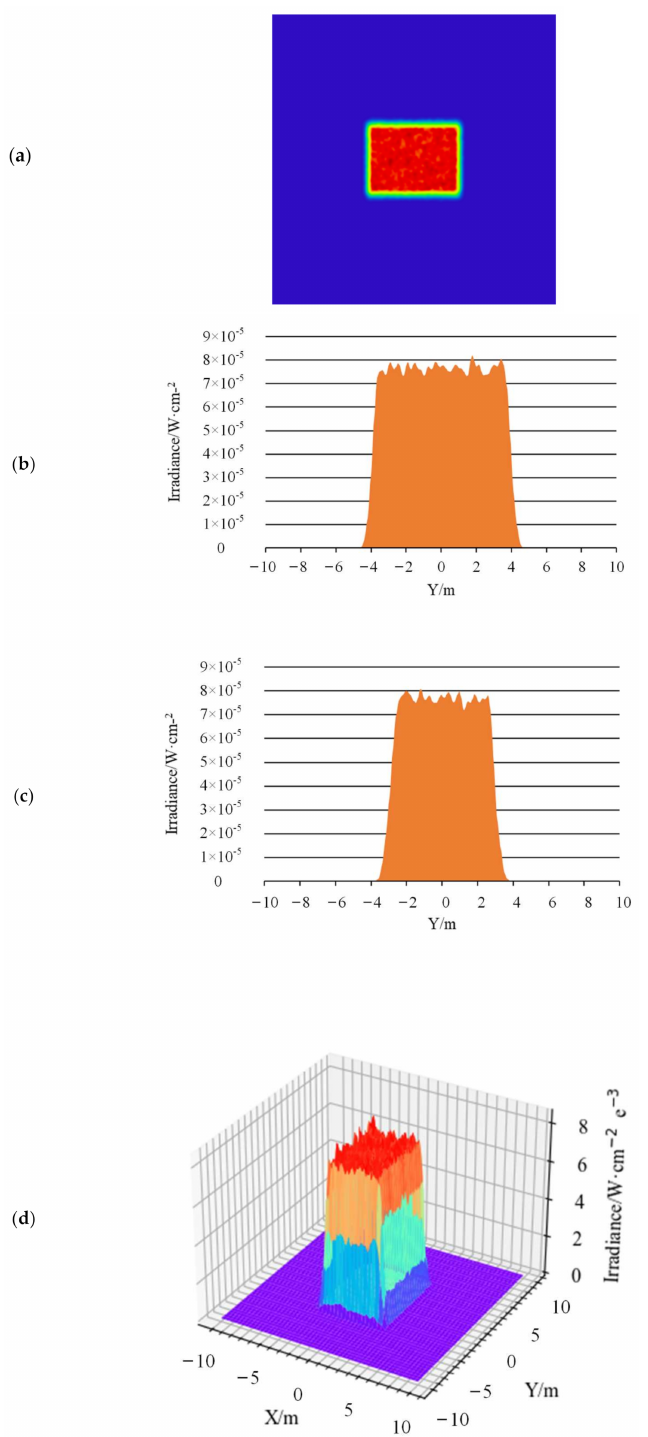
Figure 22. Laser spot and energy distribution at distance of 500 m: ( a ) Light spot; ( b ) Energy distribution in the horizontal direction; ( c ) Energy distribution in the vertical direction; ( d ) 3D energy